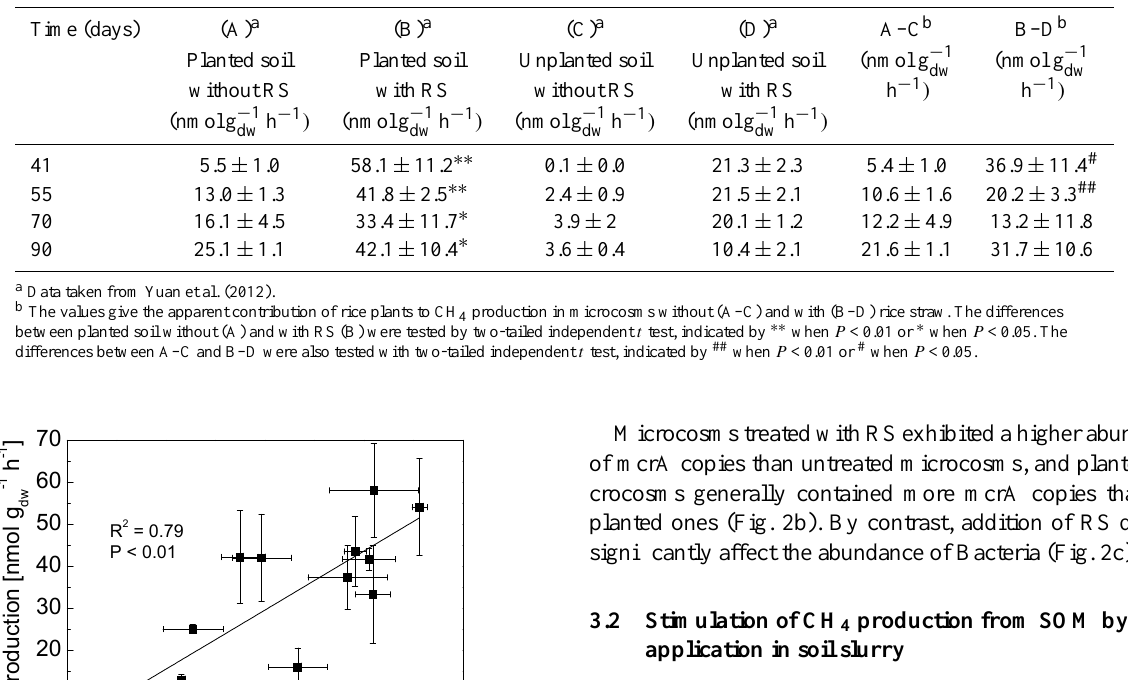
Table 1. CH 4 production rates in soil sampled from microcosms with and without rice plant and rice straw (RS), mean ± SD ( n = 4).